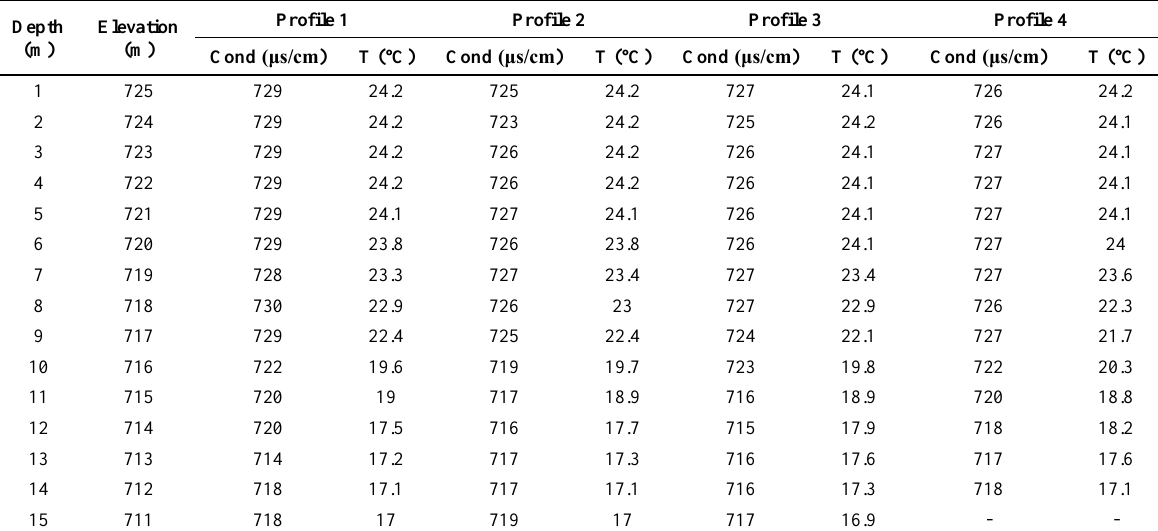
Table 3. Conductivity and temperature values at selected profiles